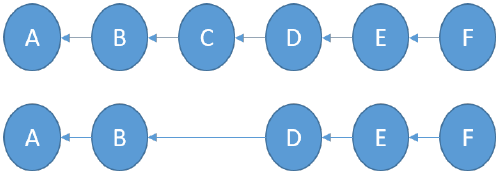
Figure 8. Chain formation.